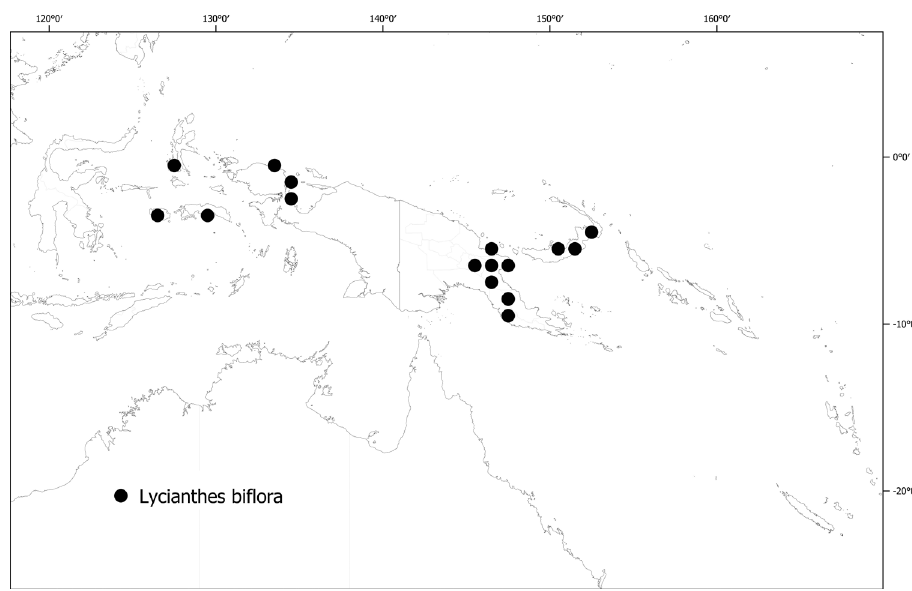
Figure 12. Distribution of Lycianthes biflora (only for region treated in this